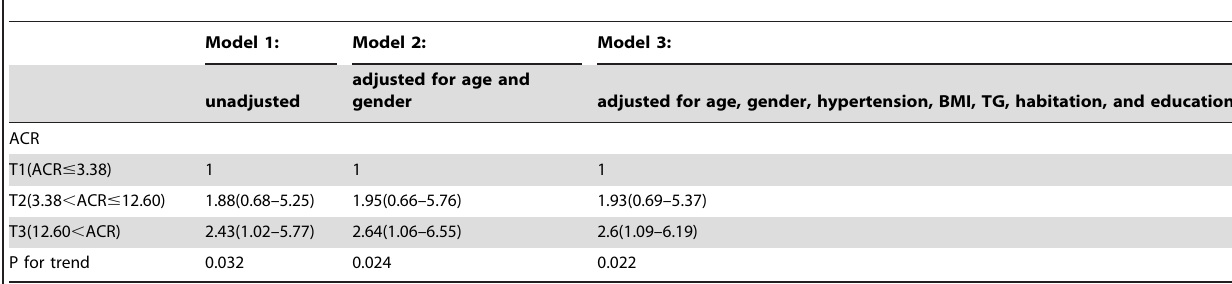
Table 2. Association between ACR and prevalence of high IOP (18 mmHg or more) in Korean type 2 diabetic population without renal impairment (n=402).